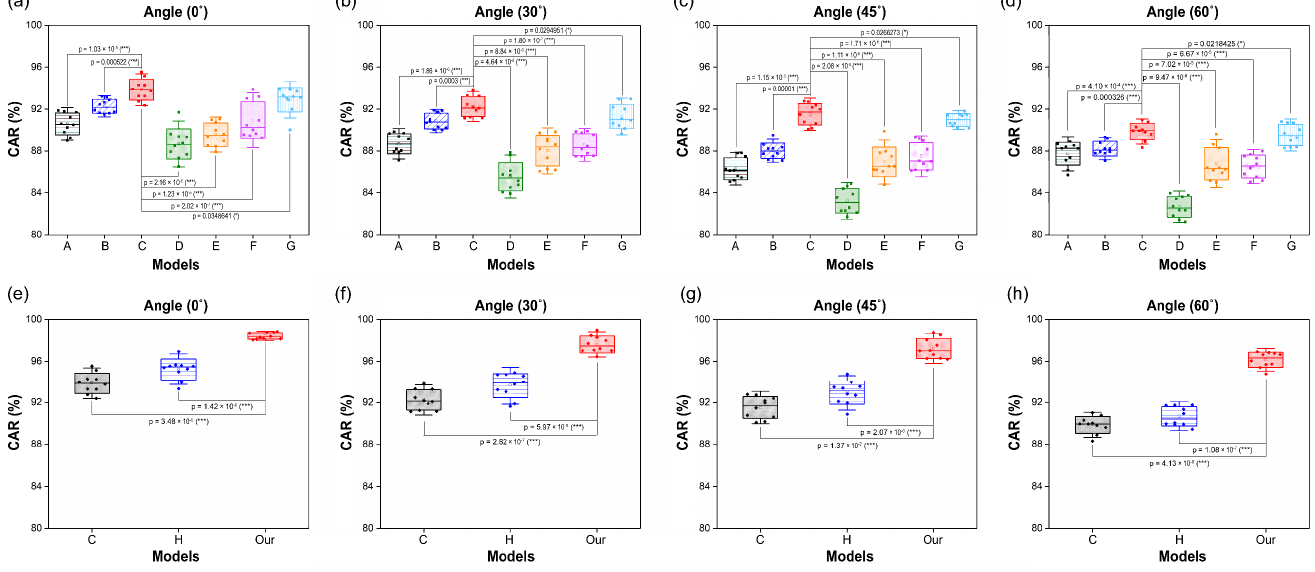
Figure 10. Comparison between different models and the proposed model based on mean accuracy of the last 10 epochs: ( a – d ) Convolutional layer and recurrent layer; ( e – h ) Transcription layer. Error bars represent standard deviation. Asterisks represent statistical significance-based t -tests between each group (* for p < 0.05, ** for p < 0.01, and *** for p < 0.001).